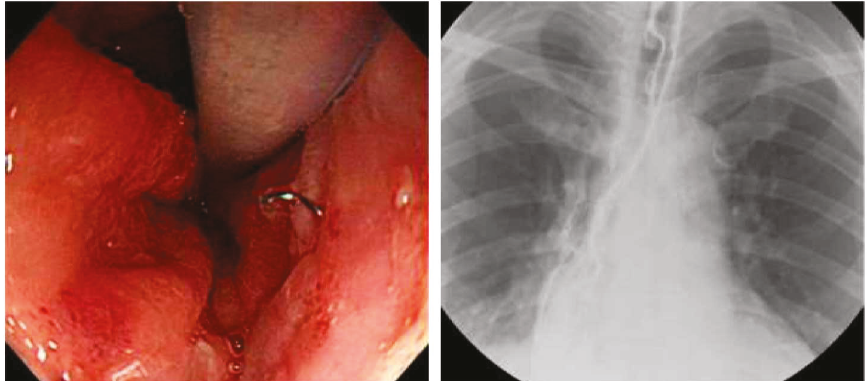
Figure 3: Endoscopic image and esophagography showing complete closure of the leakage after completion of the E-VAC therapy. Table 1: Baseline characteristics of the study patients ( n = 12 ). Variable